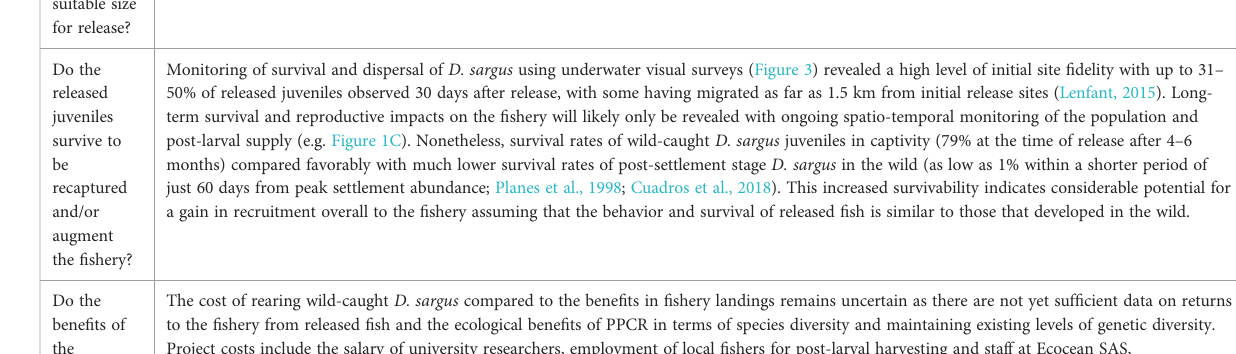
TABLE 3 ‘ Measuring success ’ – Case study: Diplodus sargus in the French Mediterranean. Success measure